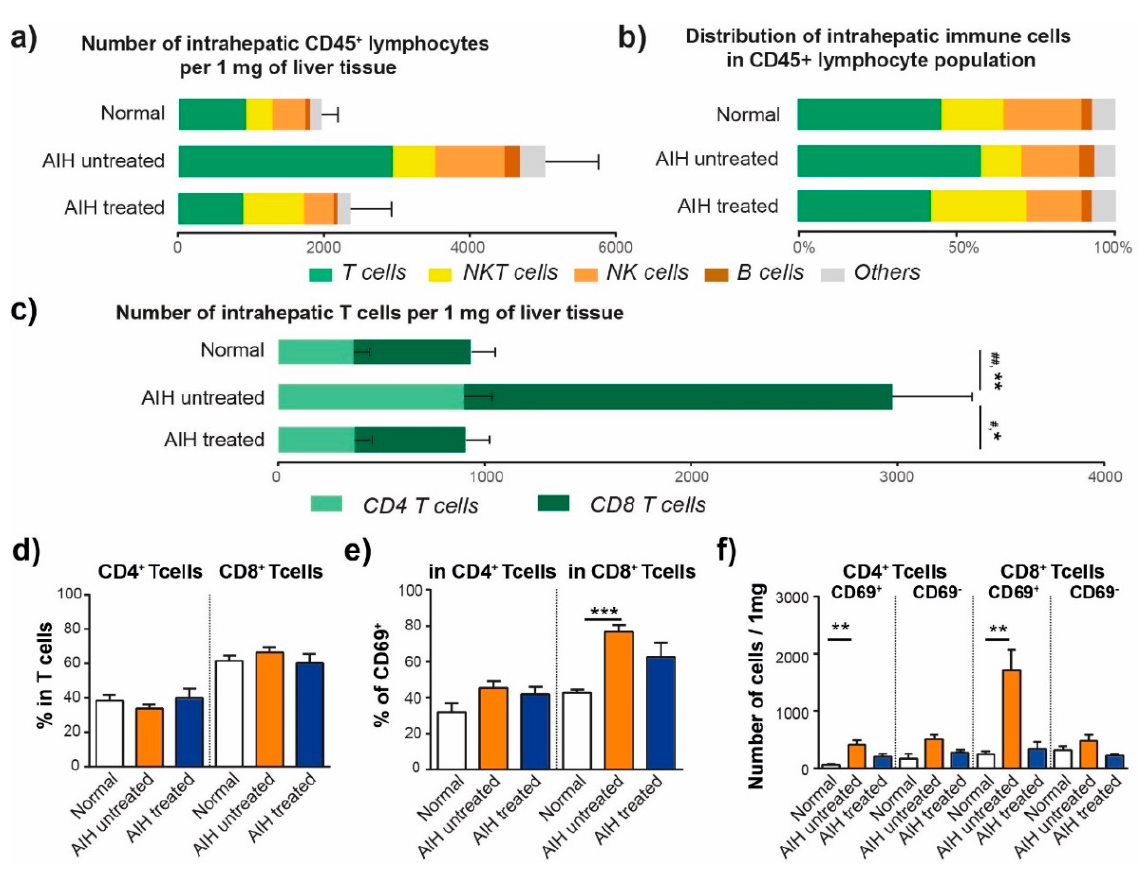
Figure 1. Number and distribution of intrahepatic lymphocytes is modified in AIH. ( a ) Estimated number of CD45 + lymphocytes per 1 mg of liver tissue. ( b ) Frequency of intrahepatic immune cells in CD45 + lymphocytes. ( c ) Estimated number of intrahepatic T cells per 1 mg of liver tissue. # p < 0.05, ## p < 0.01 represent statistically significant difference in number of CD4 + T cells between groups, * p < 0.05, ** p < 0.01 represent statistically significant difference in number of CD8 + T cells between groups. Kruskal-Wallis test with Dunn multiple comparison post-test. ( d ) Frequency of intrahepatic CD4 + T cells and CD8 + T cells in T cell population. ( e ) Frequency of intrahepatic CD69 + cells in CD4 + T cell and in CD8 + T cell population. ( f ) Estimated number of CD69 + or CD69 - CD4 + T cells and CD69 + or CD69 - CD8 + T cells per 1 mg of liver tissue. * p < 0.05, ** p < 0.01, *** p < 0.001be- tween groups, Kruskal-Wallis test with Dunn multiple comparison post-test. Data are expressed as mean ± SEM. Normal ( n = 10), AIH untreated ( n = 11) and AIH treated ( n = 5). Importantly, the number of intrahepatic CD4 + T cells and CD8 + T cells was normal- ized in AIH patients during treatment, with significant decrease in number of cells when compared to AIH untreated group, Figure 1c. The ratio of intrahepatic CD4 + T cells to CD8 + T cells was similar in all groups, with CD8 + T cells representing approximately 65% of the T cell population (Figure 1d). The massive increase of number of CD8 + T cells (Figure 1c) was associated with sig- nificantly higher frequency of CD8 + T expressing activation marker CD69 in the AIH un- treated group compared to Normal group (76.6 ± 3.9 vs. 42.6 ± 2.1% of CD69 + cells per CD8 + T cells, p = 0.0020, Figure 1e). Based on the estimated number of cells, untreated AIH is characterized by the accumulation of both, activated CD69 + CD4 + and CD69 + CD8 + T cells in the liver, while the population of CD69 − T cells does not statistically differ between groups (Figure 1f). 3.3. High Frequency of PD-1 + and 4-1BB + T Cells in the Liver of Patients with AIH Next, we analyzed the distribution of immune checkpoint molecules on the cell sur- face of CD4 + and CD8 + T cells, including inhibitory PD-1, TIM3, LAG3, CTLA4 and stim- ulatory 4-1BB and OX40 molecules (Figure 2).